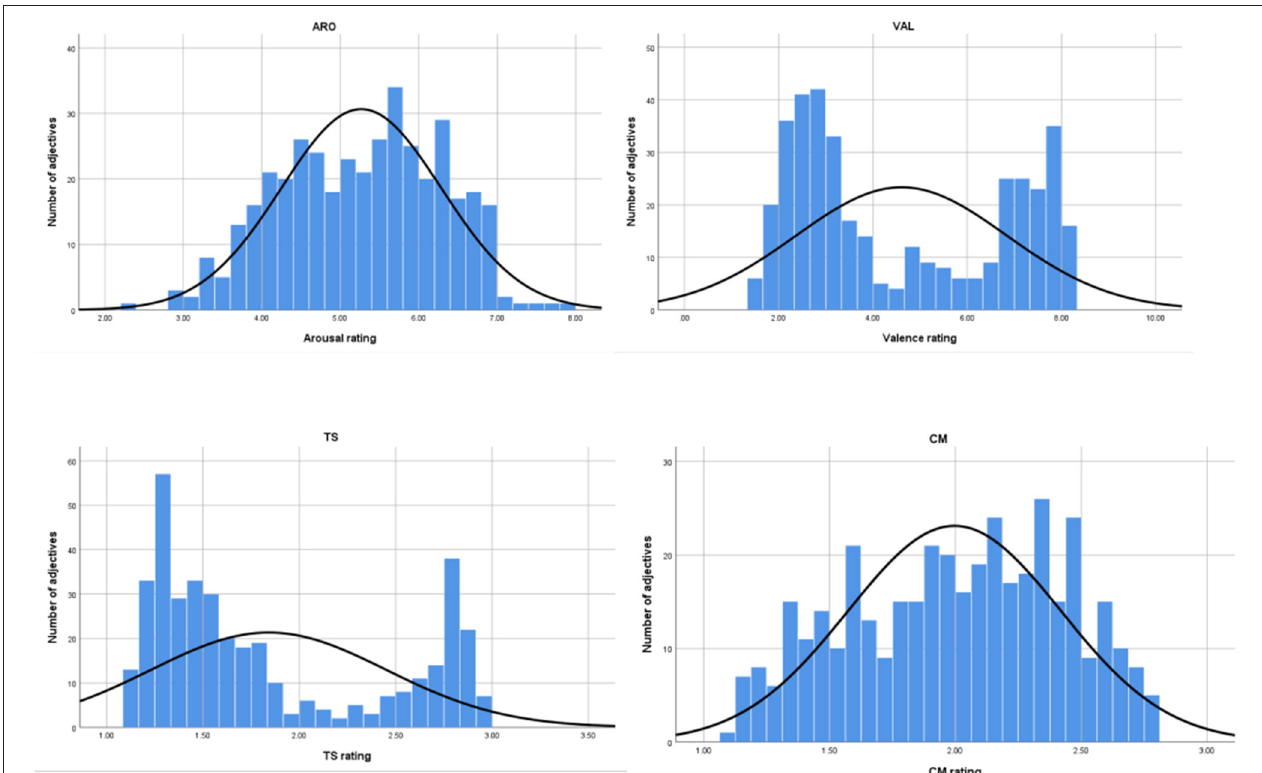
FIGURE 2 | Histograms presenting the number of adjectives rated in one-point intervals of the scales of the respective dimensions’ (ARO, arousal; VAL, valence; TS, trait-state; CM, competence-morality).